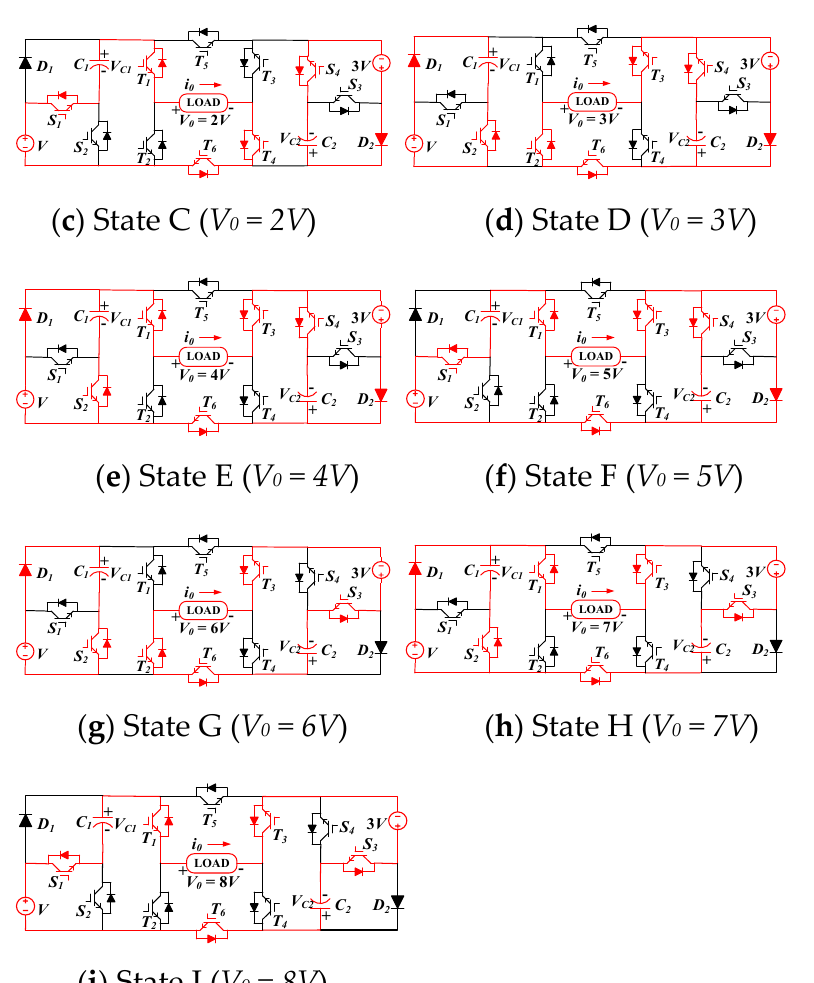
Figure 3. Conducting path for positive half-cycle modes. Total standing voltage ( TSV ) is one of the most important parameters while design- ing different inverter topologies. TSV is defined as the sum of the maximum blocked volt- age (stress) across the semiconductor switches and diodes when the output voltage of all possible levels is generated at the output.